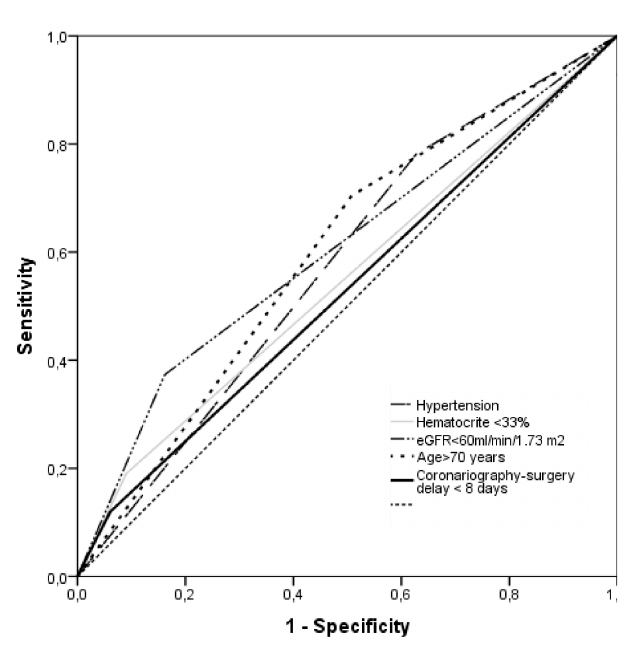
Fig. 1 – Changes of white blood cells (WBC) and C-reactive protein (CRP) levels in two